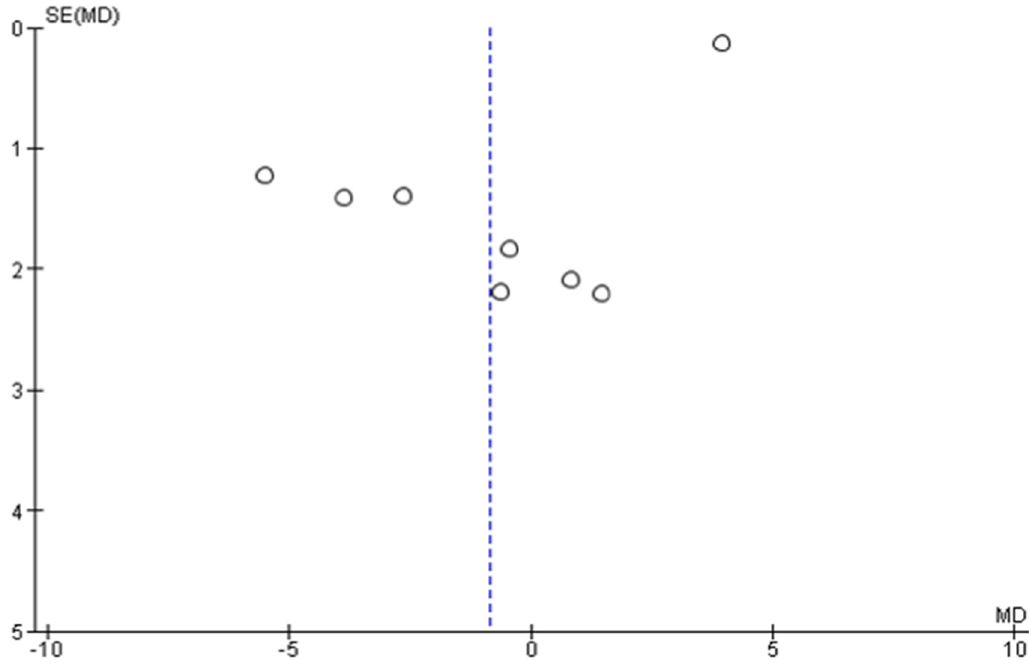
Figure 8. Funnel plot summary for secondary outcome qualitative anxiety/depression and QoL assessment (OHIP) from baseline up to the final follow-up timepoint.